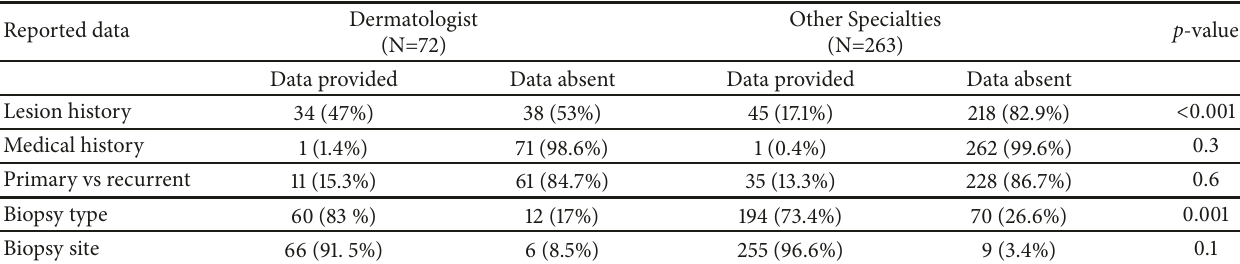
Table 1: Data provided by clinicians in request